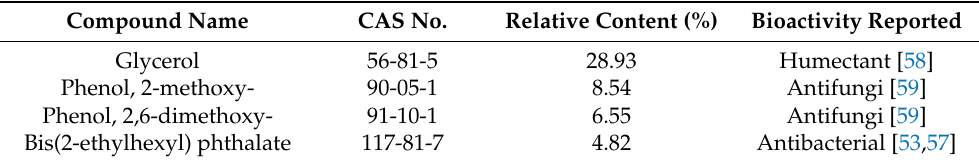
Table 5. Dominant compounds found in the ethyl-acetate extract from the fungus combs and their bioactivities.